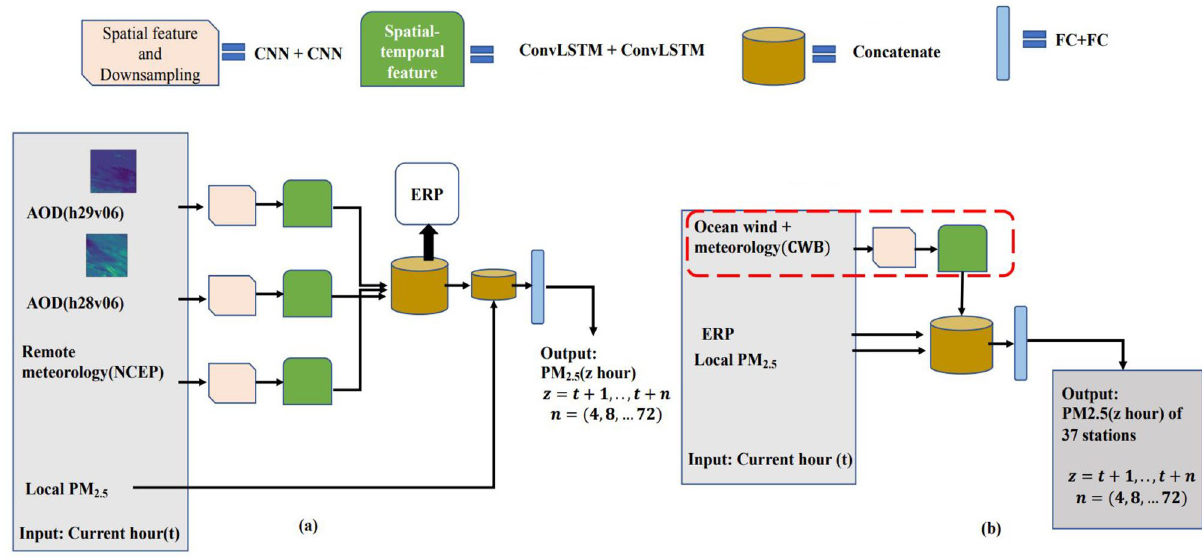
Figure 2. STRI model components STRI_fe ( a ) and STRI_p ( b ) with modifications indicated by red dashed